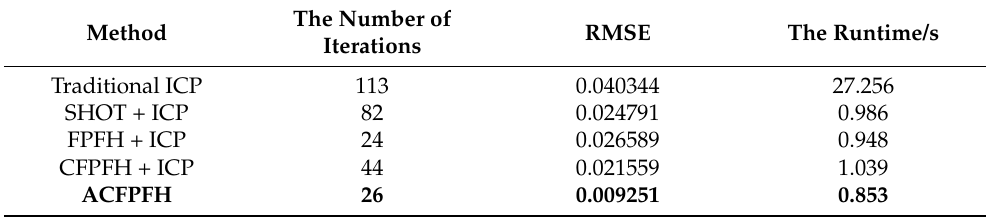
Table 4. RMSE and elapsed time comparison of different feature